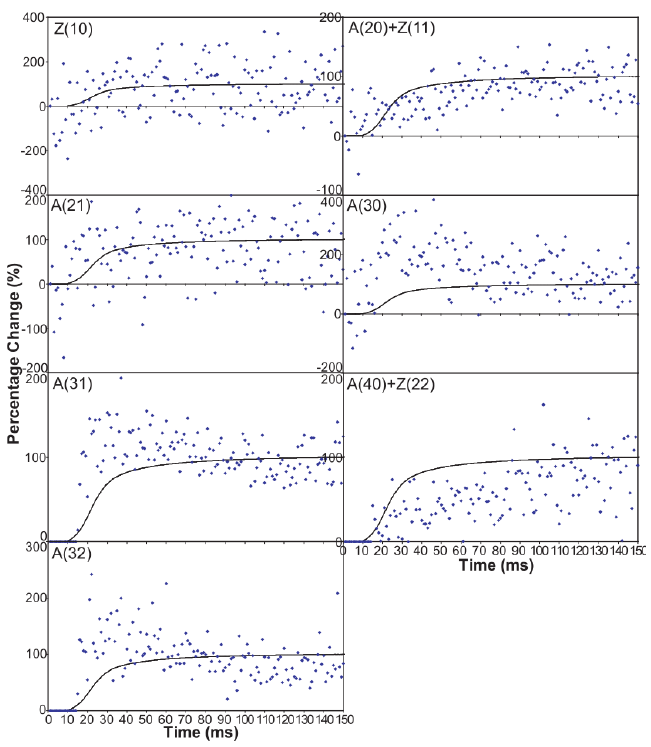
Figure 6. Intensity time-courses of the equatorial reflections, other than the A(10) and A(11), visible in the time series with partial SL control. The time-course of each reflection is shown on a separate plot in blue, as labelled, with the tension as a continuous line in grey. For comparison, the time-courses have been normalised with respect to their average values over 100 ms in the relaxed state (0%) and 100 ms at the plateau of contraction (100%) to show percentage of maximum change as in Figures 4 and 5.